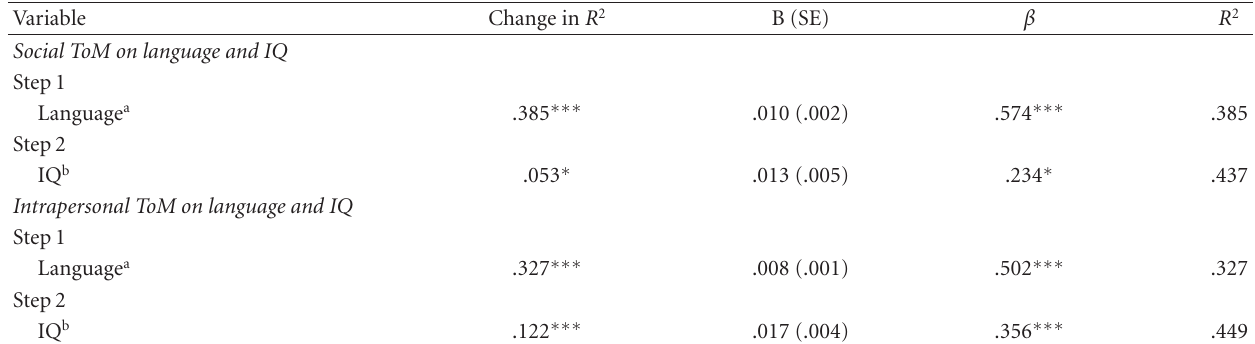
Table 4: Regressions of composite ToM scores on language and IQ.